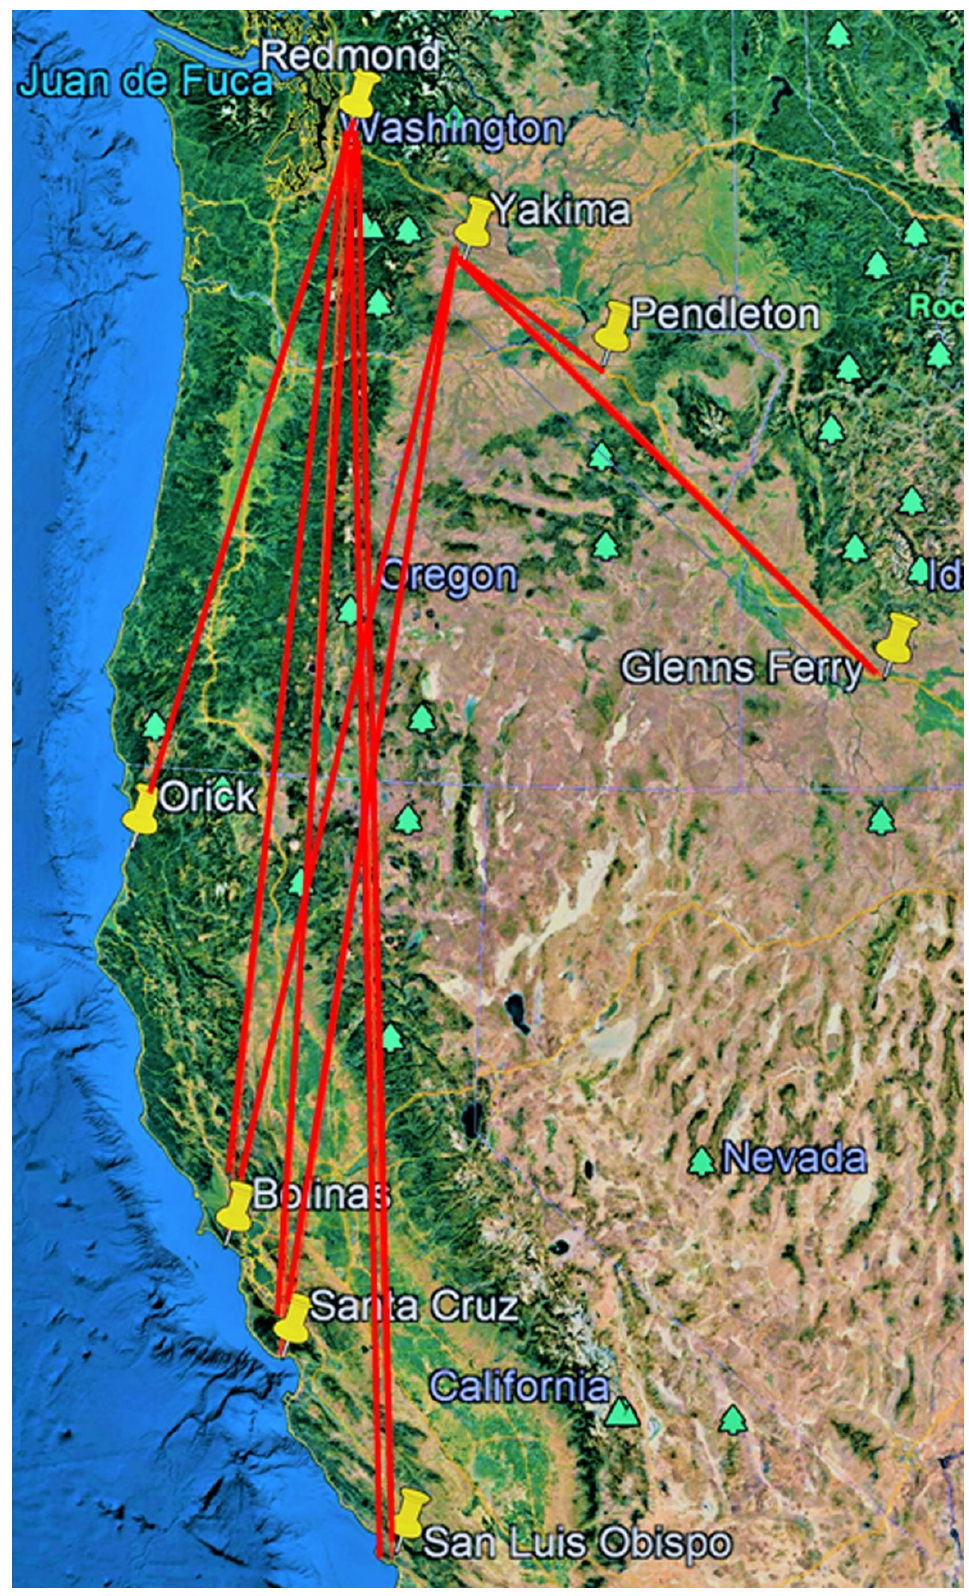
Figure 2. Release–recovery lines (N to S) for captive-reared tagged monarchs released in Washington during 2017–2019.